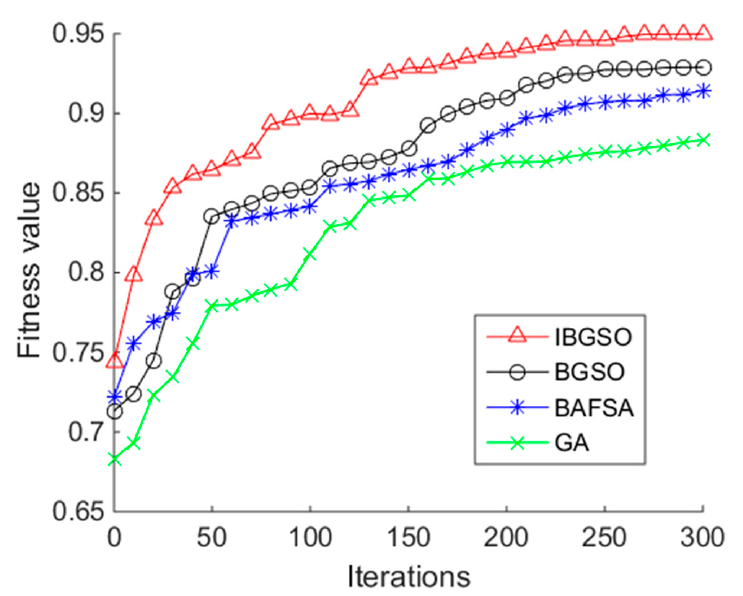
Figure 5. Relationship between the fitness value of the heuristic algorithms and the iterations using the OPPORTUNITY dataset.